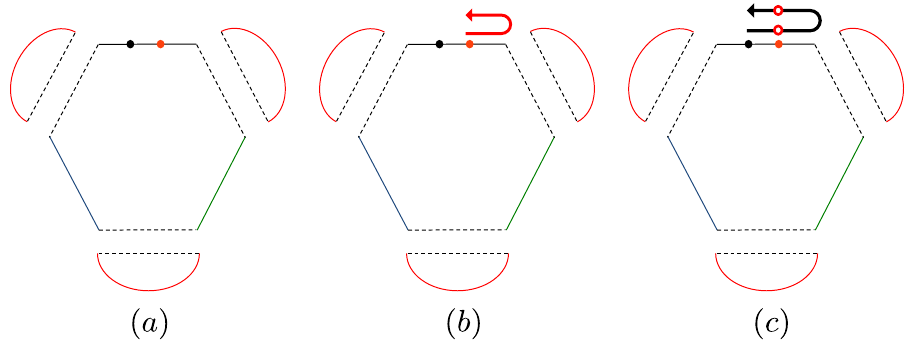
Figure 20 . Physical interpretation of the sum over partitions. The black dot denotes a magnon with u 1 and the red dot denotes a magnon with u 2 . ( a ) The (cid:12)rst term in the sum (5.11), which is just a hexagon form factor with u 1 and u 2 . ( b ) The second term in the sum (5.11). To (cid:13)ip the momentum, the second magnon has to travel to the right boundary and get re(cid:13)ected. This leads to the propagation factor shown in (5.11). ( c ) The third term in the sum (5.11). In this case, the (cid:12)rst magnon needs to travel to the right edge and get re(cid:13)ected. In the process, it passes through the second magnon twice, (cid:12)rst from the left and second from the right. This leads to additional S-matrix